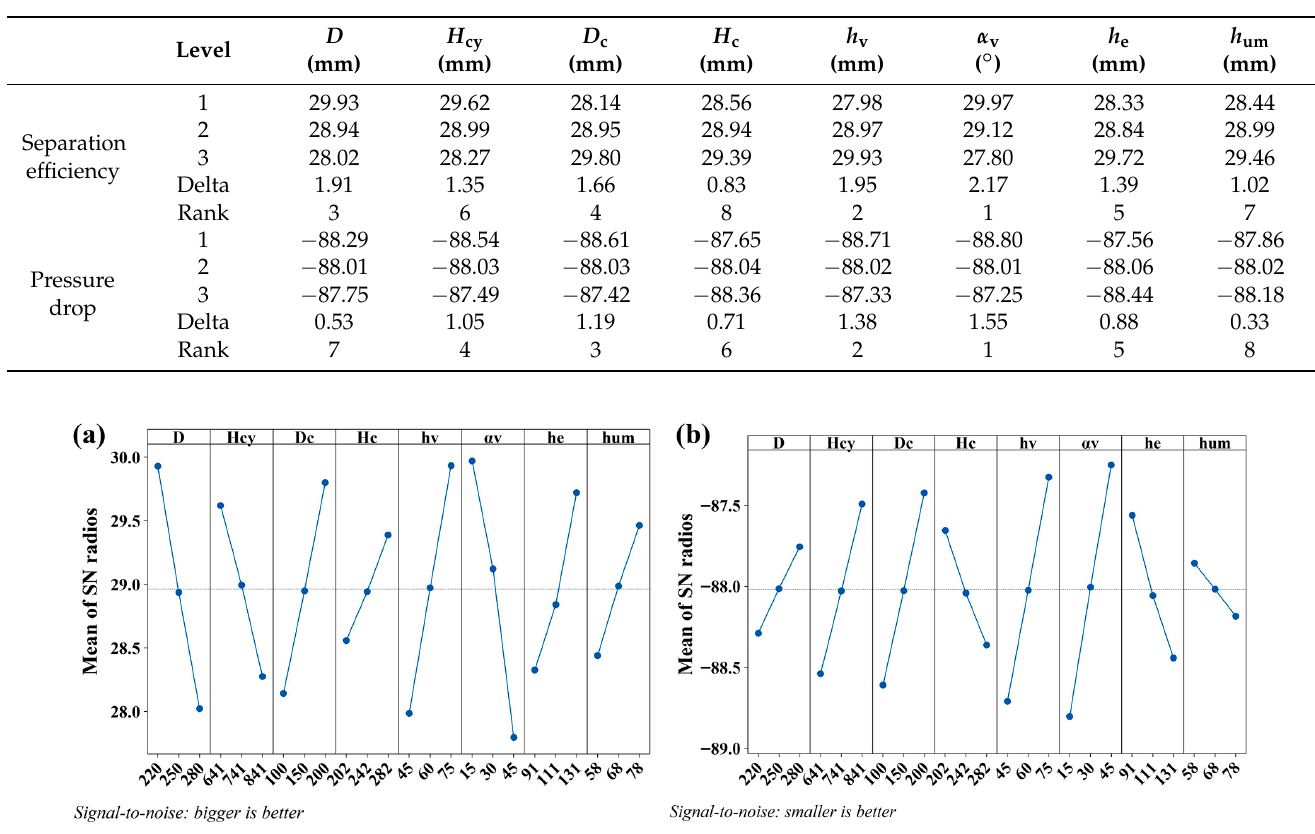
Table 6. The average SNR response table for separation efficiency and pressure drop.